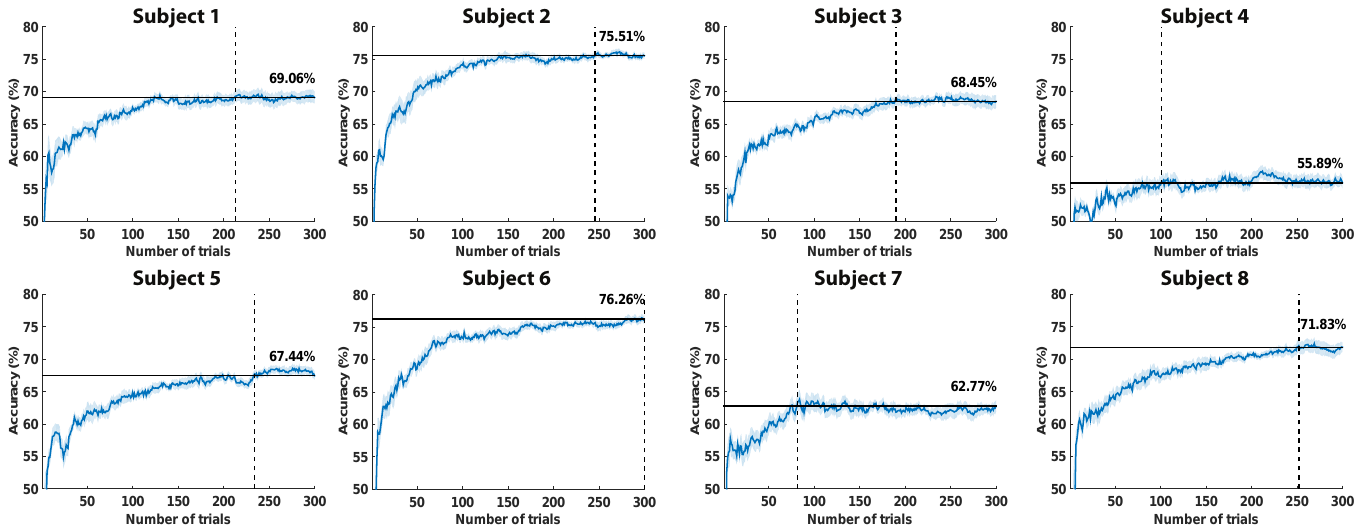
Fig 6. Accuracy from simulated standard calibration. Simulated calibration represented as accuracies computed by increasing the number of trials of the training dataset (x-axis) and testing the classifier with a fixed test set of 200 trials. In order to have a confidence measure (shadowed areas), this procedure was repeated 10 times while shuffling the data. The horizontal solid line represents the accuracy plateau (also shown above the line), whereas the dashed vertical line shows the number of trials needed to reach the plateau.